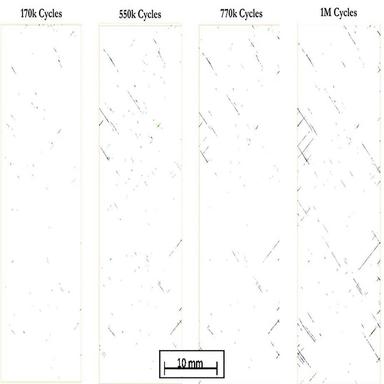
Damage distribution within an internal ply (here PLY4) at different number of cycles corresponding to µCT stops: matrix cracks in 0° (red), +45° (green) and −45° (blue) directions.